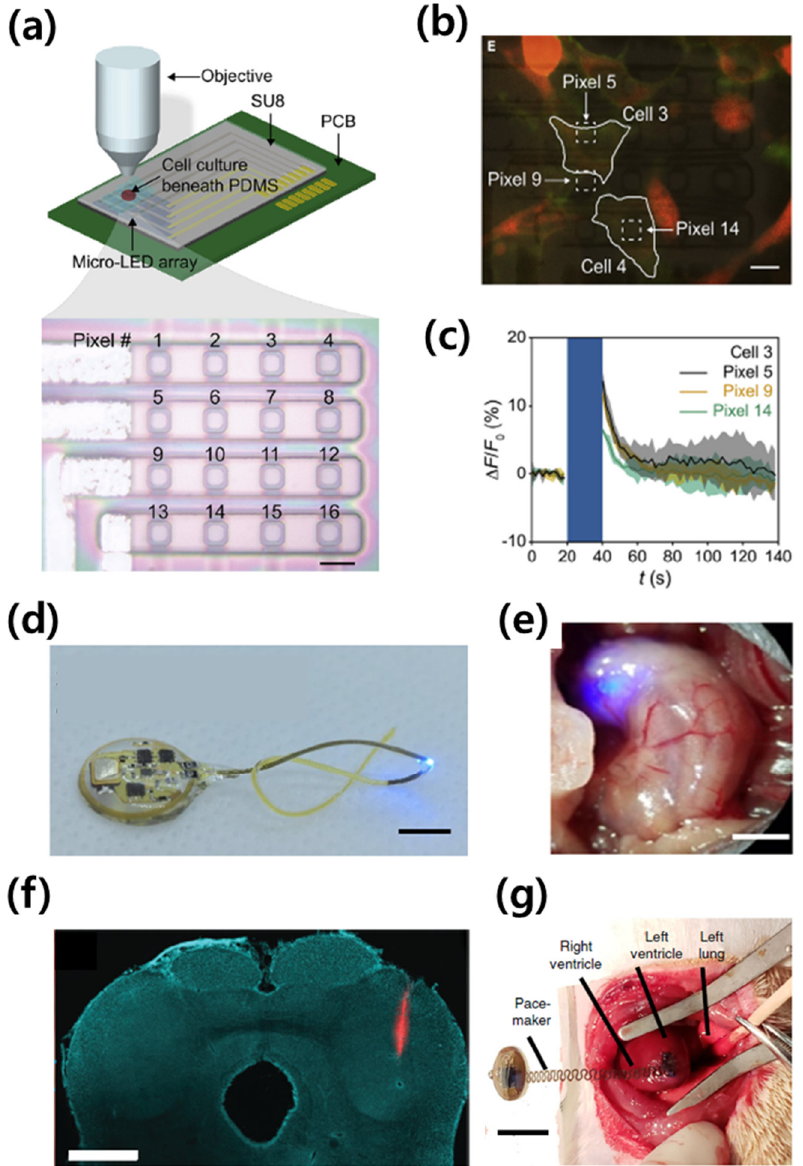
Figure 7. ( a ) Schematic image of experimental setup for µ LED-based cell imaging. ( b ) A magnified optical microscopic image of ChR2 (green, optogenetic actuator)-jRCaMP1a (red, Ca 2+ indicator)- expressed cells on 4 × 4 µ LED array. Scale bar: 10 µ m. ( c ) Fluorescence intensity ratio ( ∆ F/F 0 ) graph of cell 3 on µ LED pixels (pixel 5, 9, and 14) after optogenetic stimulations. Reproduced with permission [41]. Copyright 2019, Elsevier. ( d ) Optical image of wireless gastric optogenetic implant device. Scale bar: 5 mm. ( e ) Photograph of the implanted wireless optogenetic device with blue light in the mouse stomach. Reproduced with permission [42]. Copyright 2021, Springer Nature. ( f ) Coronal section image of mouse brain, showing DAPI-stained brain tissue region (cyan) and Dil-stained electrode region (red). Reproduced with permission [43]. Copyright 2019, Springer Nature. ( g ) Image of wireless multimodal optogenetic stimulator, which was sutured on left ventricle of the rat. Reproduced with permission [44]. Copyright 2019, Springer